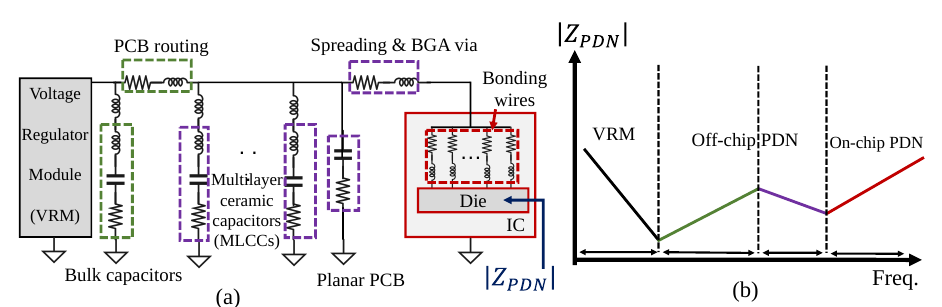
Figure 2: (a) The equivalent RLC circuit of the system’s PDN (b) Contribution of different parts of the PDN to the magnitude of the PDN impedance over